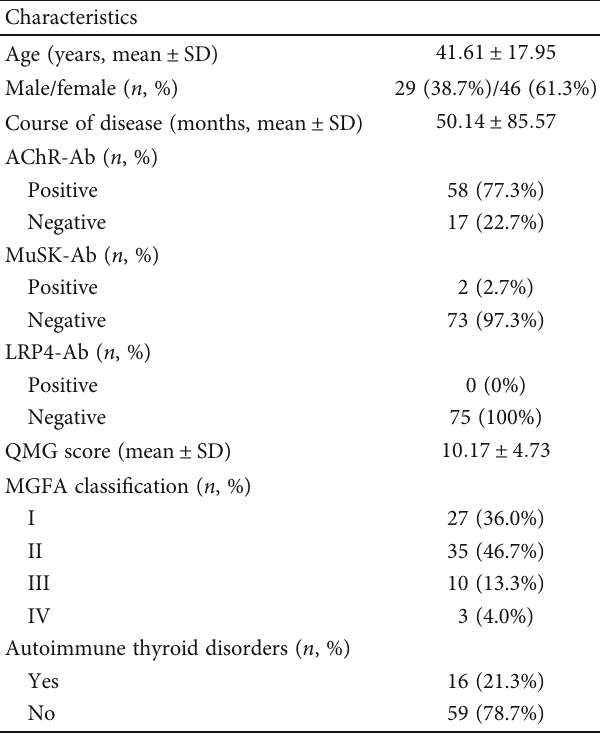
Table 1: Baseline characteristics of patients.